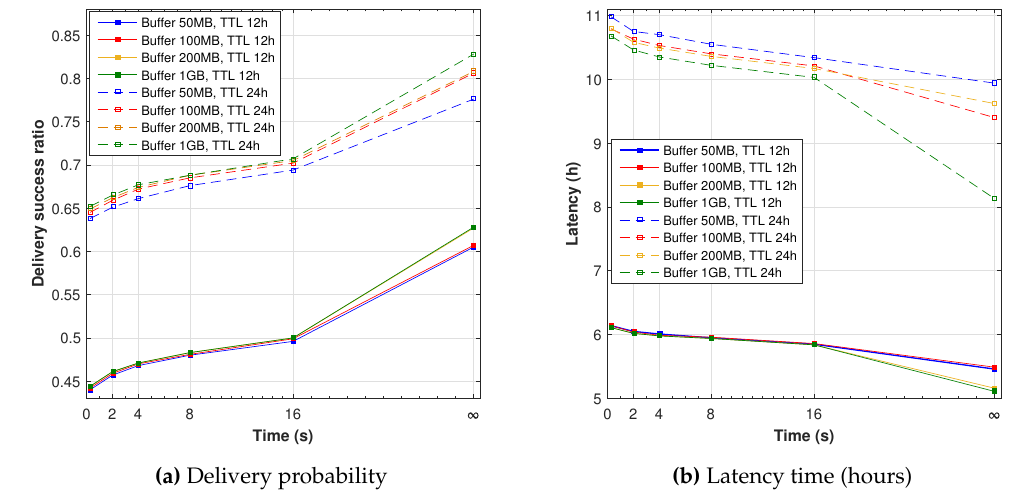
Figure 9. Average delivery success ratio and